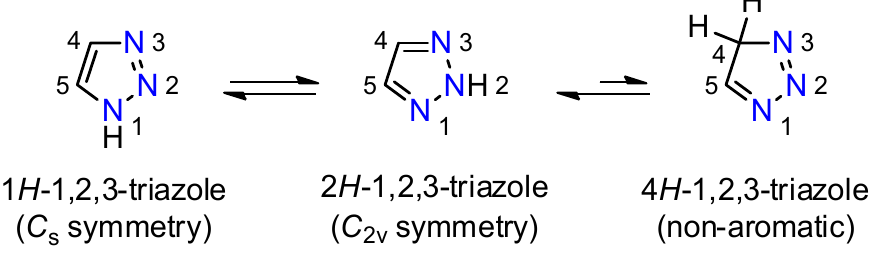
Figure 1. Tautomeric forms of the unsubstituted 1,2,3-triazole ring. 1 H NMR spectroscopic study of 1 H - and 2 H -1,2,3-triazole in toluene solution showed that 1 H -tautomer is predominant at − 98 ◦ C, while the 2 H -tautomer increased more than 97% at 27 ◦ C [4]. Four years later, the tautomeric equilibrium of gaseous